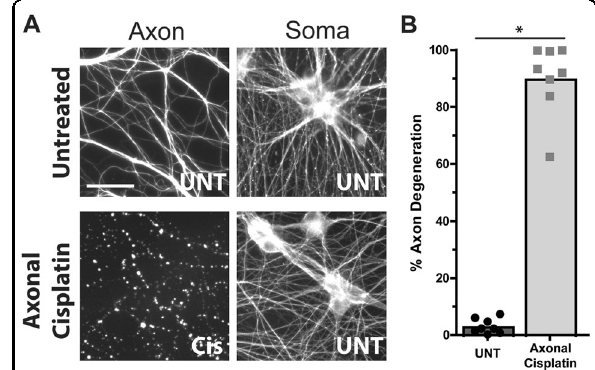
Fig. 2 Cisplatin addition to axons is suf fi cient to induce localized axon degeneration. A Neurons in micro fl uidic chambers were left untreated (UNT; Top panels) or had their axons alone (and not their soma/nucleus) exposed to cisplatin (Axonal Cisplatin; 20 μ M; Bottom panels) for 120 h and stained for tubulin. The scale bar represents 20 μ m. Representative images are shown from n = 3. B Quanti fi cation of the axon degeneration from these experiments is shown on the right ( n = 8), individual data points and mean are depicted. Paired t -test (two-tailed) (* p <